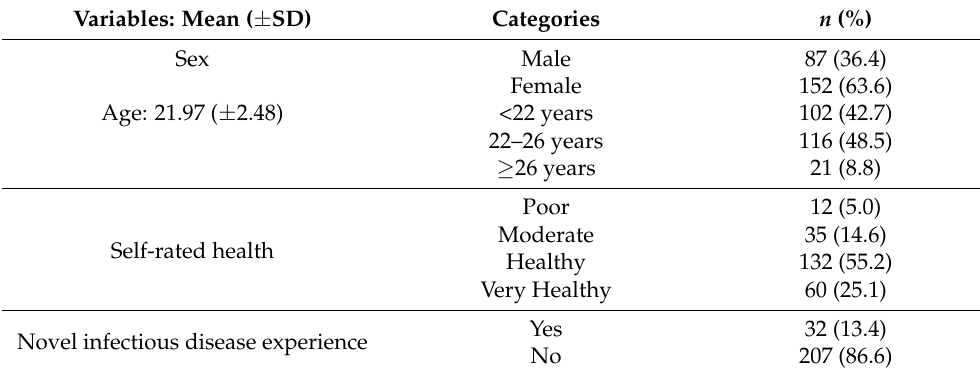
Table 1. General characteristics and COVID-19 preventive behavior ( N =